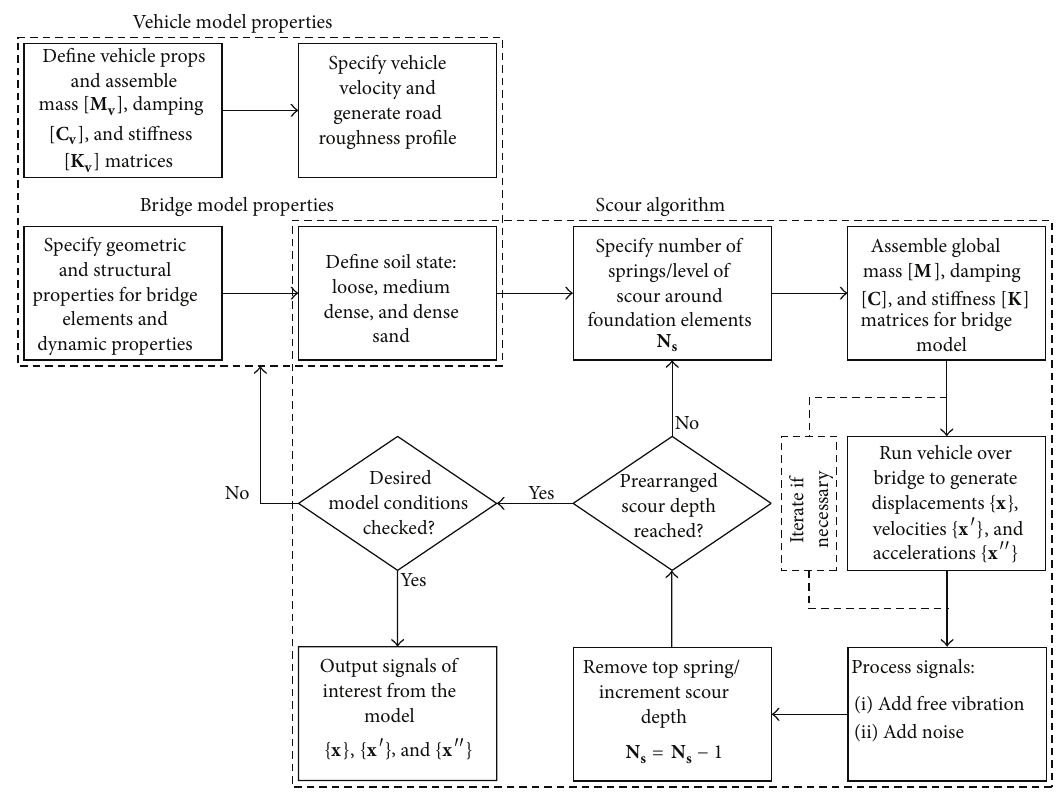
Figure 7: Scour modelling algorithm to generate analysis